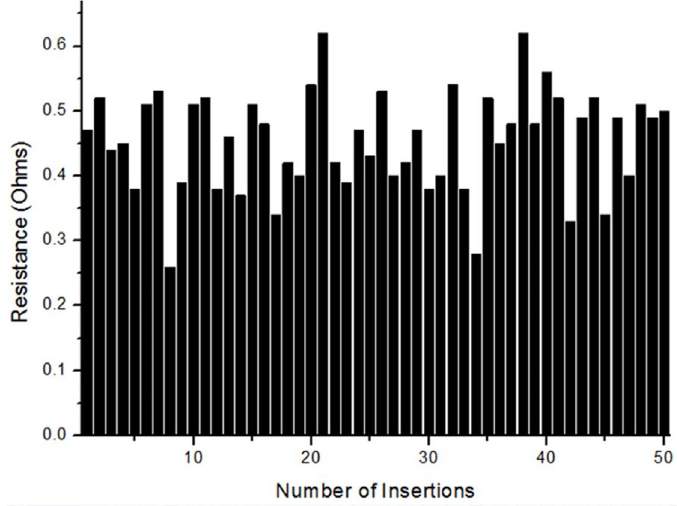
Figure 5. The contact resistances between single needle and stainless steel over 50 random insertions. The resistance varies from 0.26 to 0.62 Ω. The average contact resistance of 0.454 Ω can be calculated from the